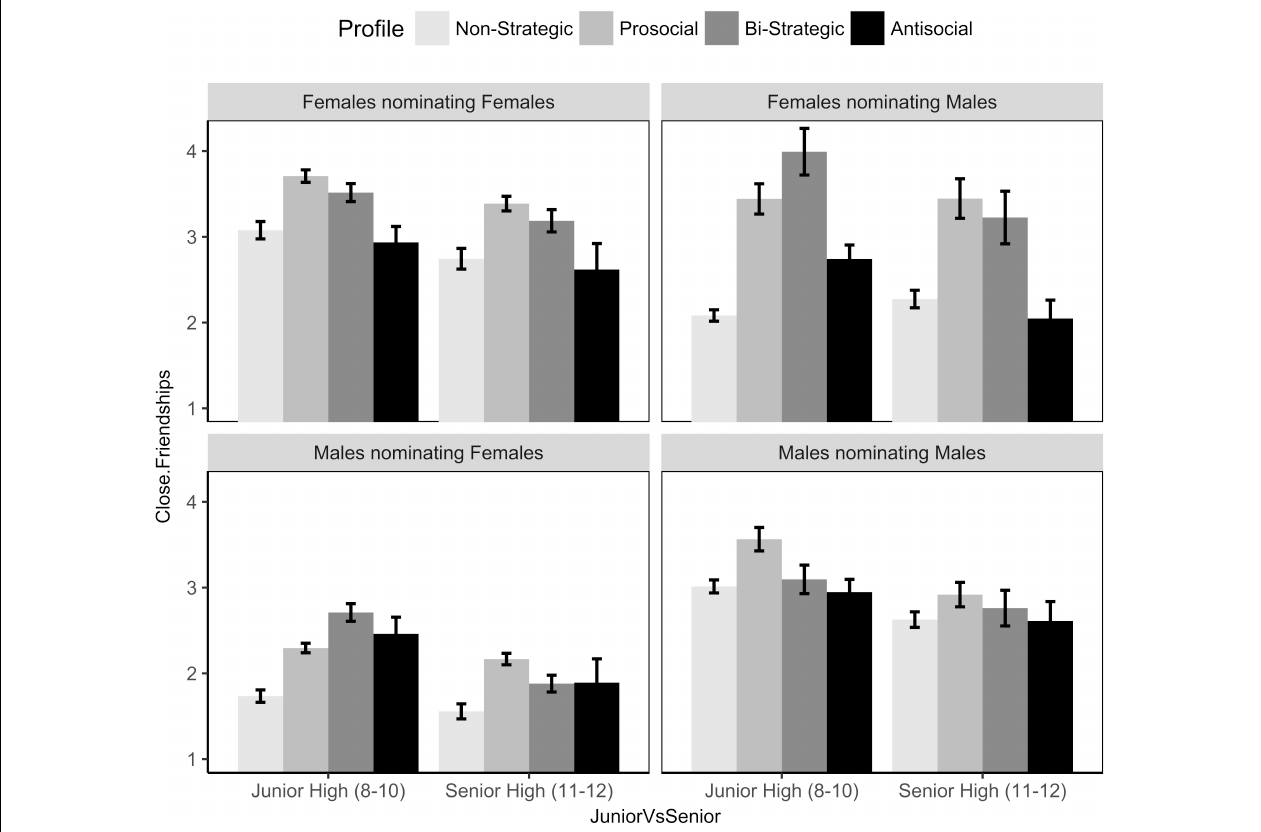
FIGURE 2 | Mean and SE of friendship nominations as a function of profile, gender, and junior versus senior. SE bars represent 95% confidence intervals, a plausible range of population means that could have created the sample means (Cumming, 2014).